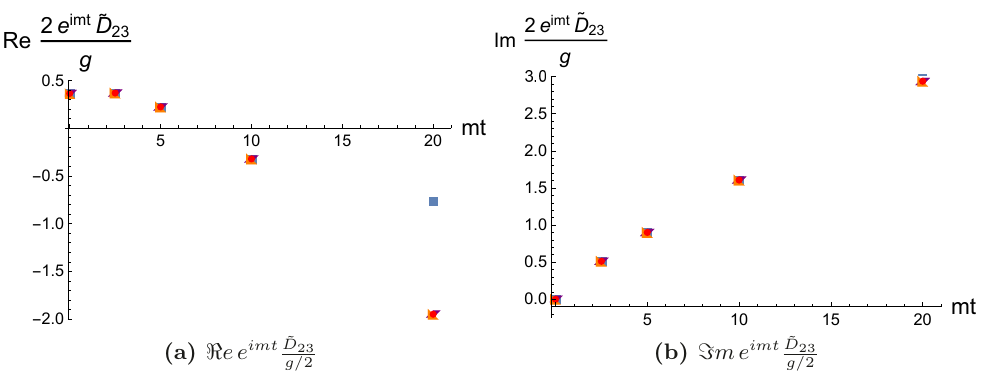
Figure 2. Real and imaginary parts of e imt ˜ D 23 for time instants mt = 0 , 2 . 5 , 5 , 10 and 20 for a g/ 2 quench in the Ising model. Results for system sizes mL = 30 , 40 , 50 and 60 are shown with blue, purple, orange and red symbols, but with a single exception these cannot really be distinguished due to their almost perfect